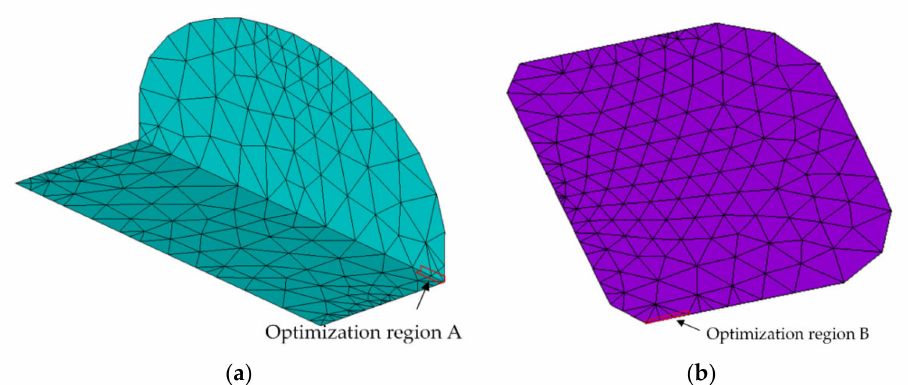
Figure 17. Contact pressure optimization region. ( a ) Optimized region of interfaces 1 and 2 (i.e., the interface between termination and solder joint); ( b ) optimized region of interface 3 (i.e., the interface between land and solder